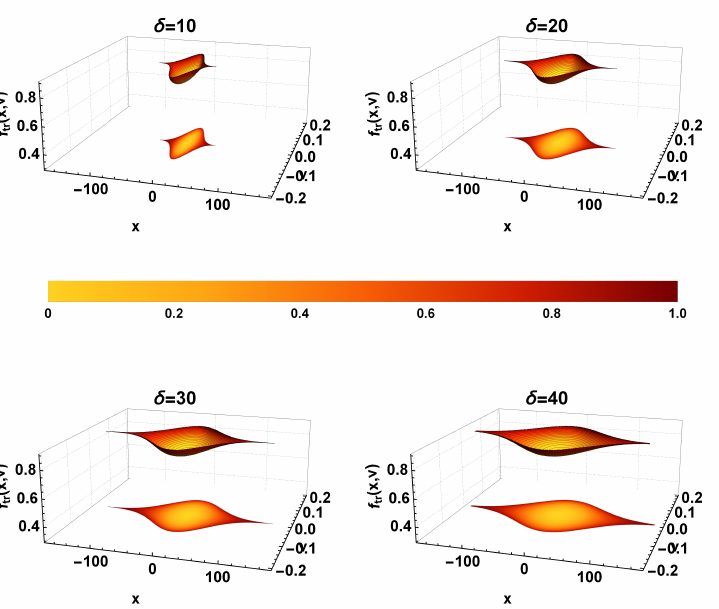
Figure 5. The same as Figure 4, except that the potential width δ is varied, while keeping T r = 0.5 and ψ = 0.01 as